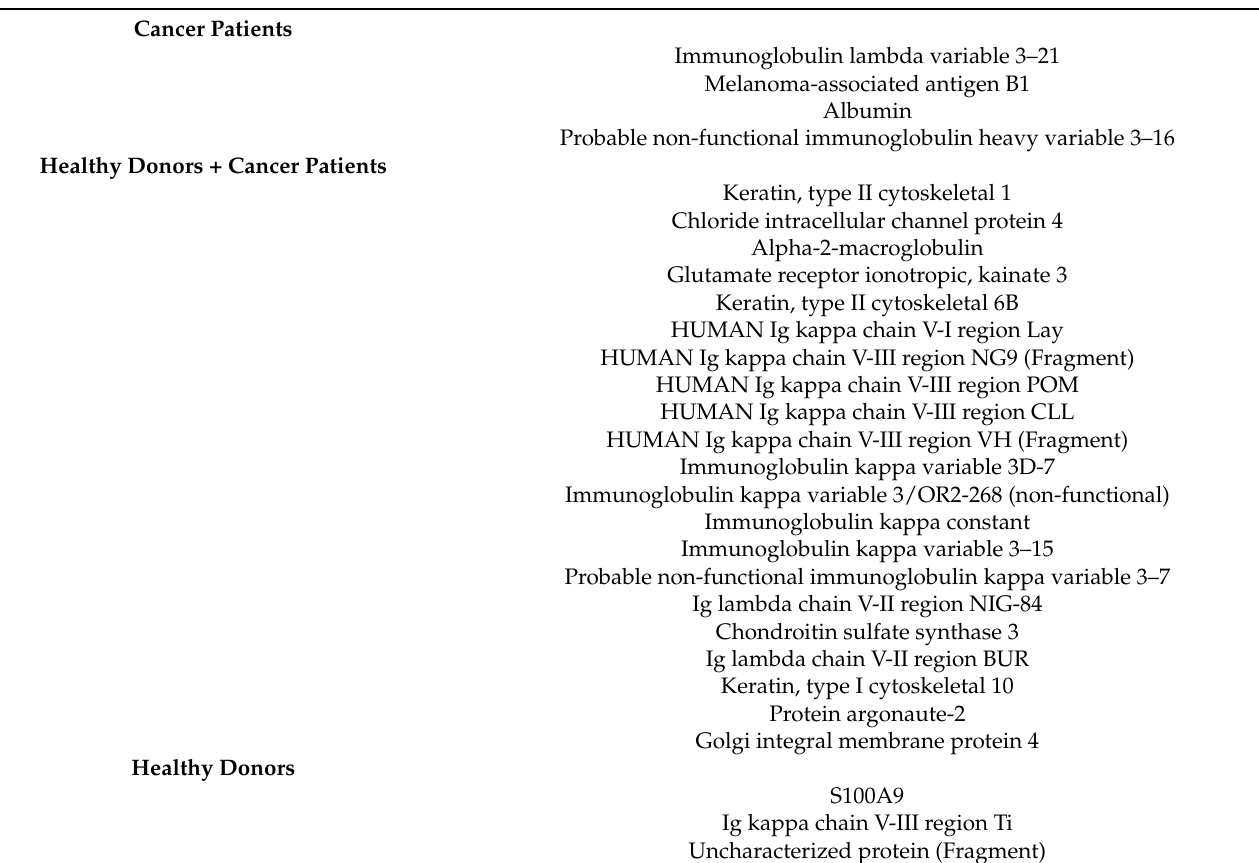
Table 1. IgG associated proteins identified by